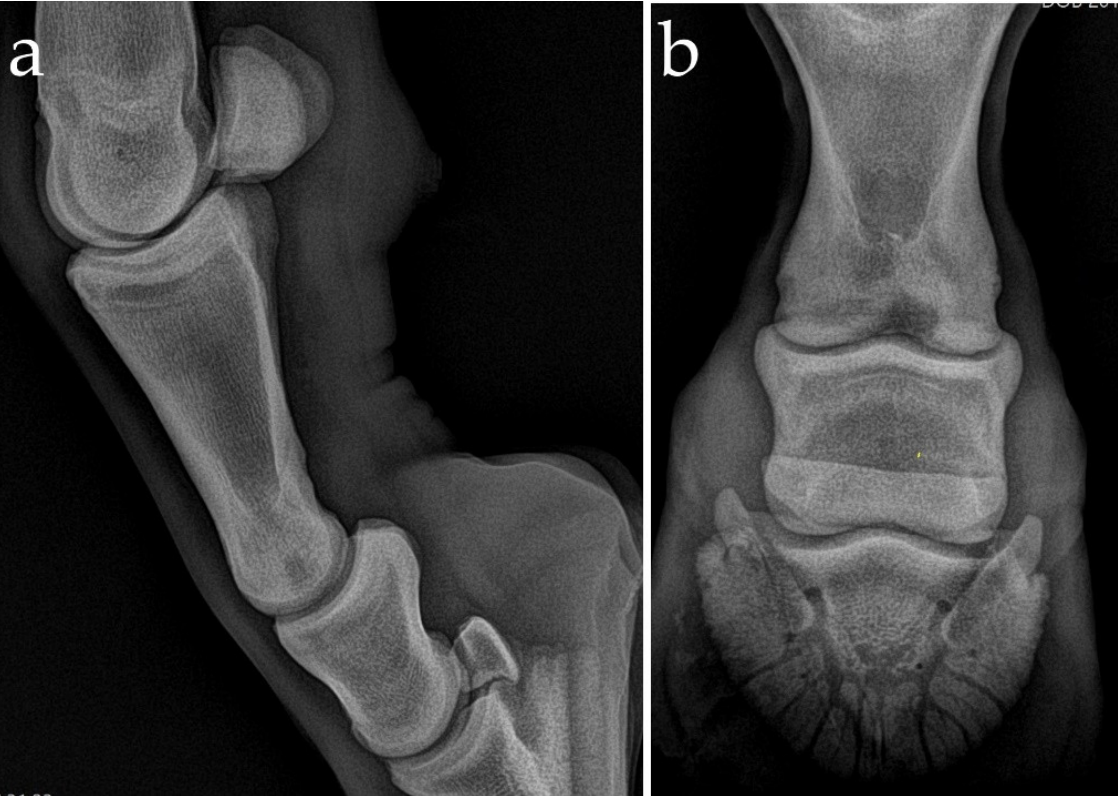
Figure 1. Lateromedial ( a ) and dorsoproximal–plantarodistal oblique ( b ) radiograph of the proximal interphalangeal joint of the left hindlimb. There is an ill-defined sagittal radiolucency within the distal subchondral bone of the proximal phalanx. Wide communication between the proximal interphalangeal joint and the osseous cyst-like lesions (OCLL) is clear on these radiographs.